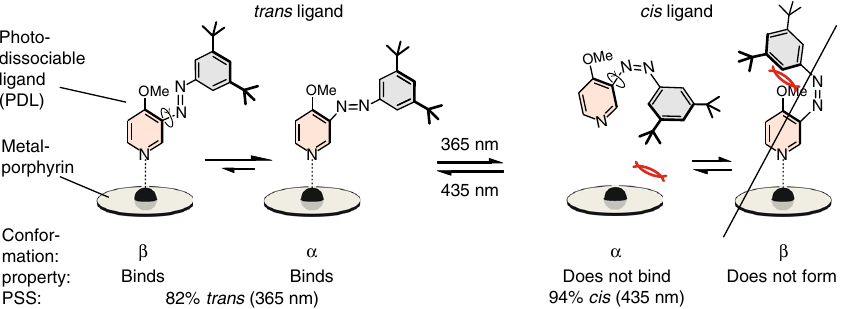
Fig. 2 Design of the photodissociable ligand (PDL) based on photoswitchable phenyl azopyridine. Irradiation with UV light (365 nm) switches the trans isomer to the cis form. Visible light triggers reisomerization back to the trans form. The photostationary states (PSS) of the two processes are trans / cis 75:25 (435 nm), and 6:94 (365 nm). The methoxy group in 4-position of the pyridine was introduced to increase the coordination strength, and to prevent the formation of the β conformation of the cis isomer. The two t -Bu groups at the phenyl ring increase steric repulsion with the porphyrin in the cis form, however, have no effect on the coordination of the trans con fi determined the complex formation constants K 1 ′ = 5862 L mol − 1 and K 2 ′ = 596 L mol − 1 (see Supplementary Figures 19b, 26-28). These formation constants were con fi rmed by NMR titration